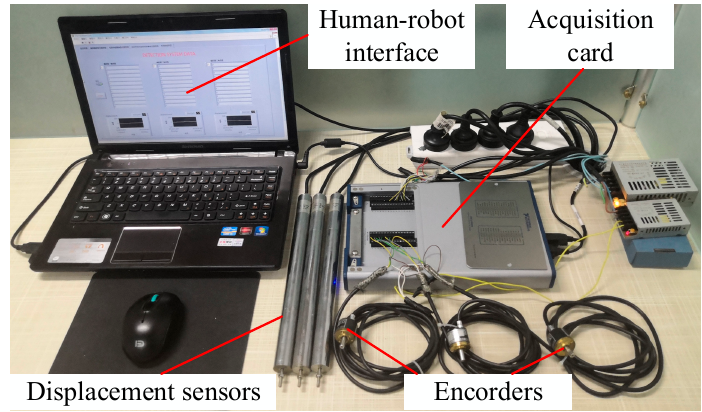
Figure 4. Diagram of the measurement system.